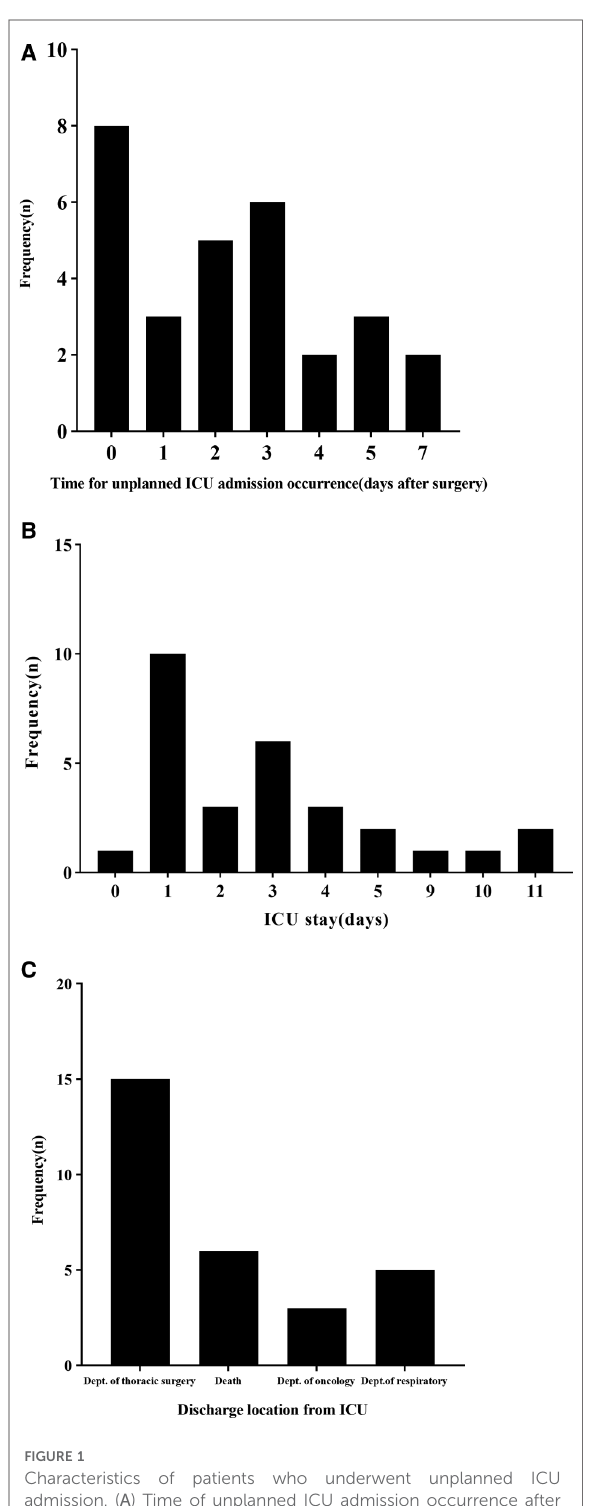
FIGURE 1 Characteristics of patients who underwent unplanned ICU admission. ( A ) Time of unplanned ICU admission occurrence after surgery. ( B ) Length of ICU stay after unplanned ICU admission. ( C ) Destinations of patients after discharge from the